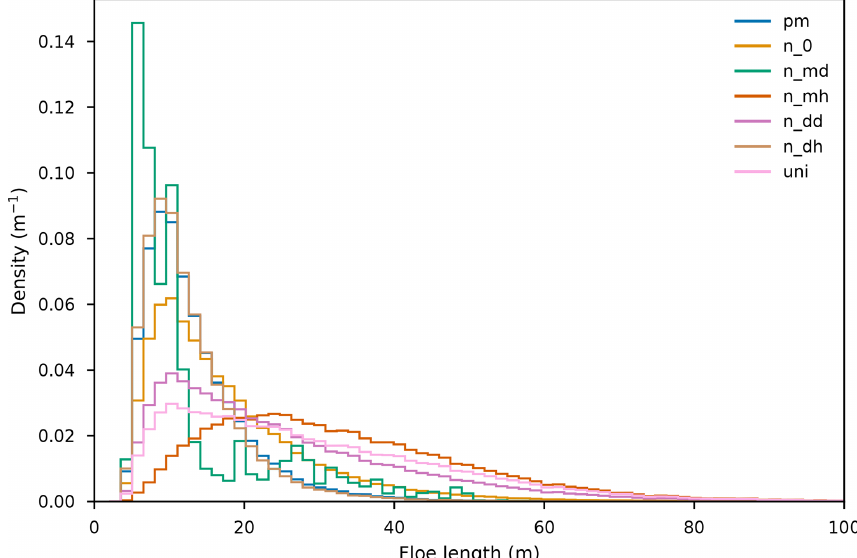
The Cryosphere, 16, 4447–4472,